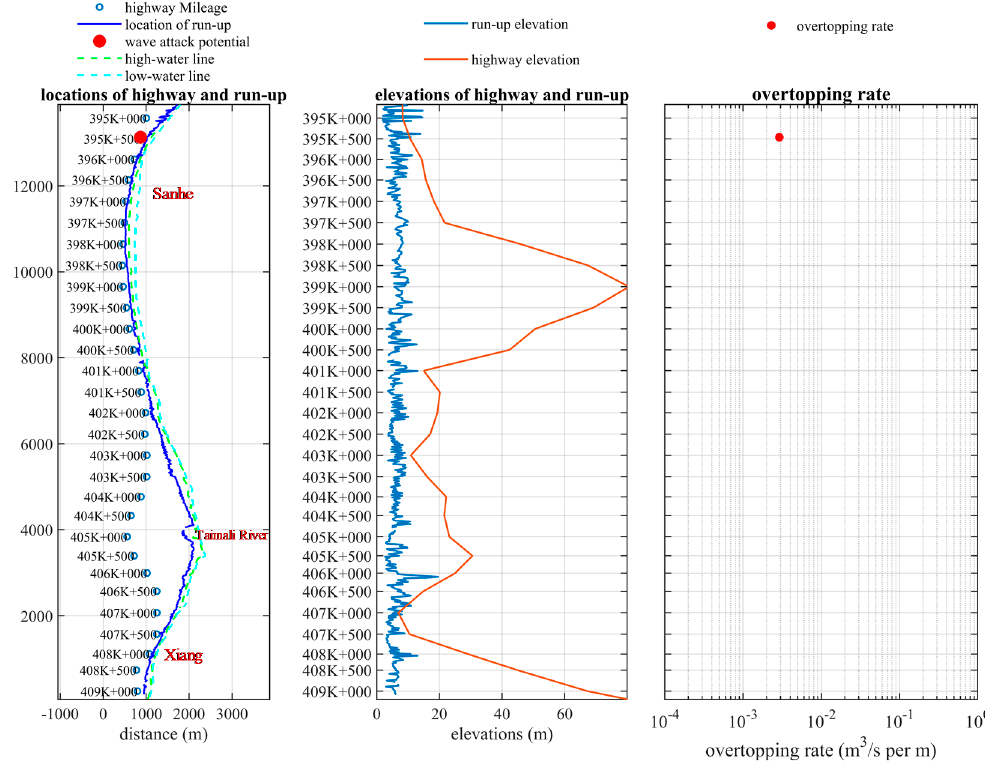
Figure 27. Map of the potential for wave attacks along the Provincial Highway in Region C.